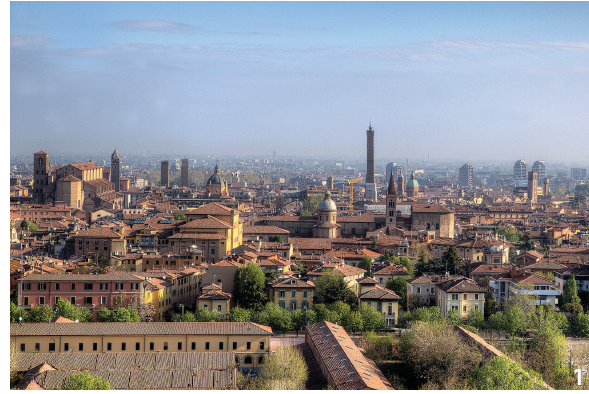
Figure 1 Bologna City Centre. (Source: Lorenzo Click, Flickr)